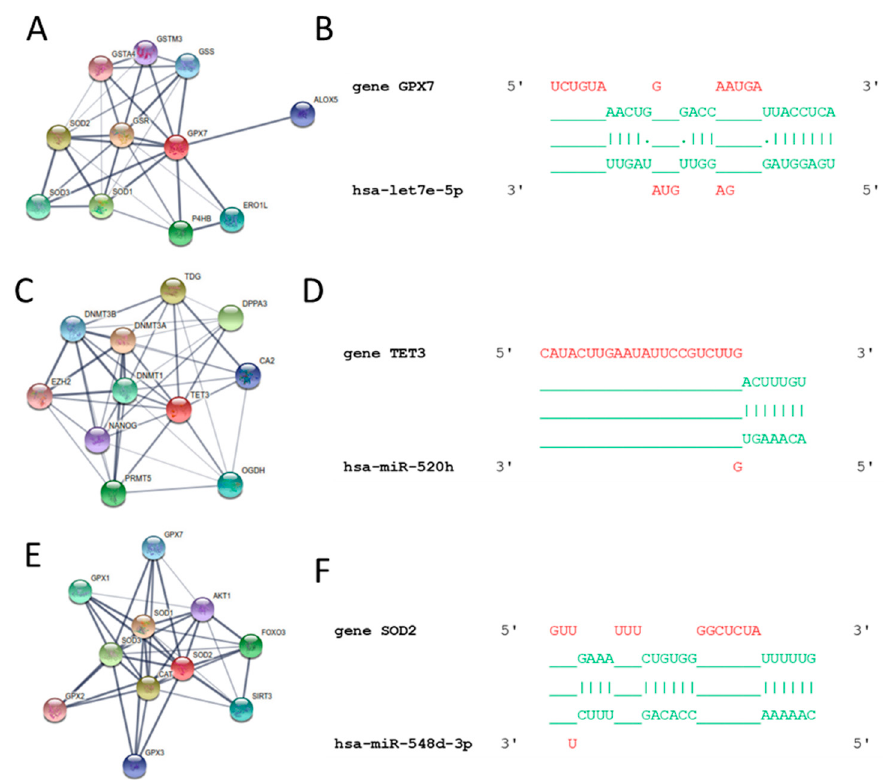
Figure 2. Bioinformatics analysis. String protein interaction of ( A ) GPX7 and ( B ) GPX7 in silico interactions with the 3 ′ UTR region. String protein interaction of ( C ) TET3 and its in silico interactions with the 3 ′ UTR region in ( D ). String protein interaction of ( E ) SOD2 and its in silico interactions with the 3 ′ UTR region in ( F ).